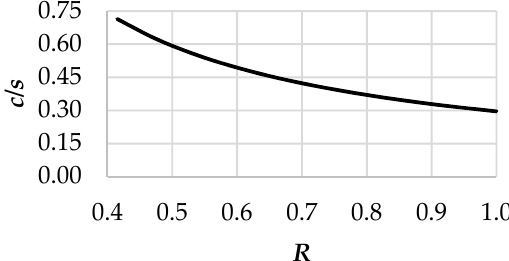
Figure 8. Blade solidity as a function of dimensionless radius ( R = r / r tip ).